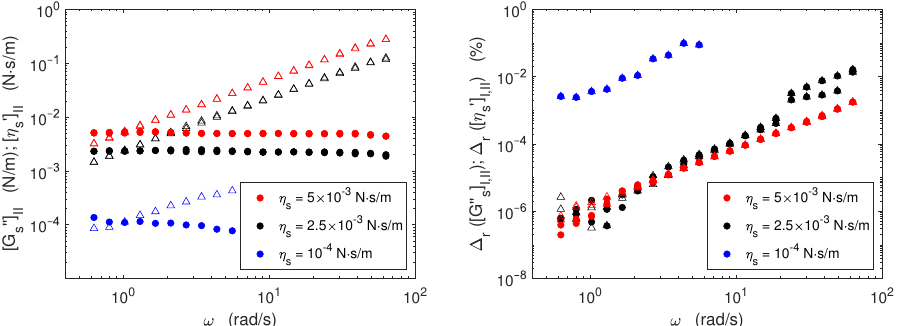
Figure 11. Left panel: Interfacial loss modulus, [ G (cid:48)(cid:48) s ] II (triangles), and interfacial viscosity, η (cid:48) s (circles) as a function of oscillation frequency, ω . Right panel: Relative difference, ∆ r ([ G (cid:48)(cid:48) s ] I , II ) , between the loss modulus of the thin films of silicone oil obtained with PV-I and PV-II as a function of frequency. In the left panel of Figure 12, we show plots of the values obtained for the inter- ( γ ) , as a function of the strain, γ , for the silicone oil films with facial loss modulus, G (cid:48)(cid:48) s ∼ 1.5 × 10 − 2 N/m) and η s = 5 × 10 − 3 N · s/m (red triangles; expected loss modulus G (cid:48)(cid:48) s ∼ 3 × 10 − 4 N/m)). In these η s = 10 − 4 N · s/m (blue circles; expected loss modulus G (cid:48)(cid:48) s measurements the frequency was set at f = 0.5 Hz ( ω = π rad/s), and the oscillation am- plitude was varied. The left panel shows that the measurements are well within the linear regime, and good agreement with the expected values of the loss modulus is